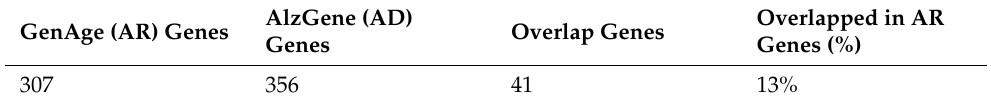
Table 4. Comparison of AR and positive AD genes.